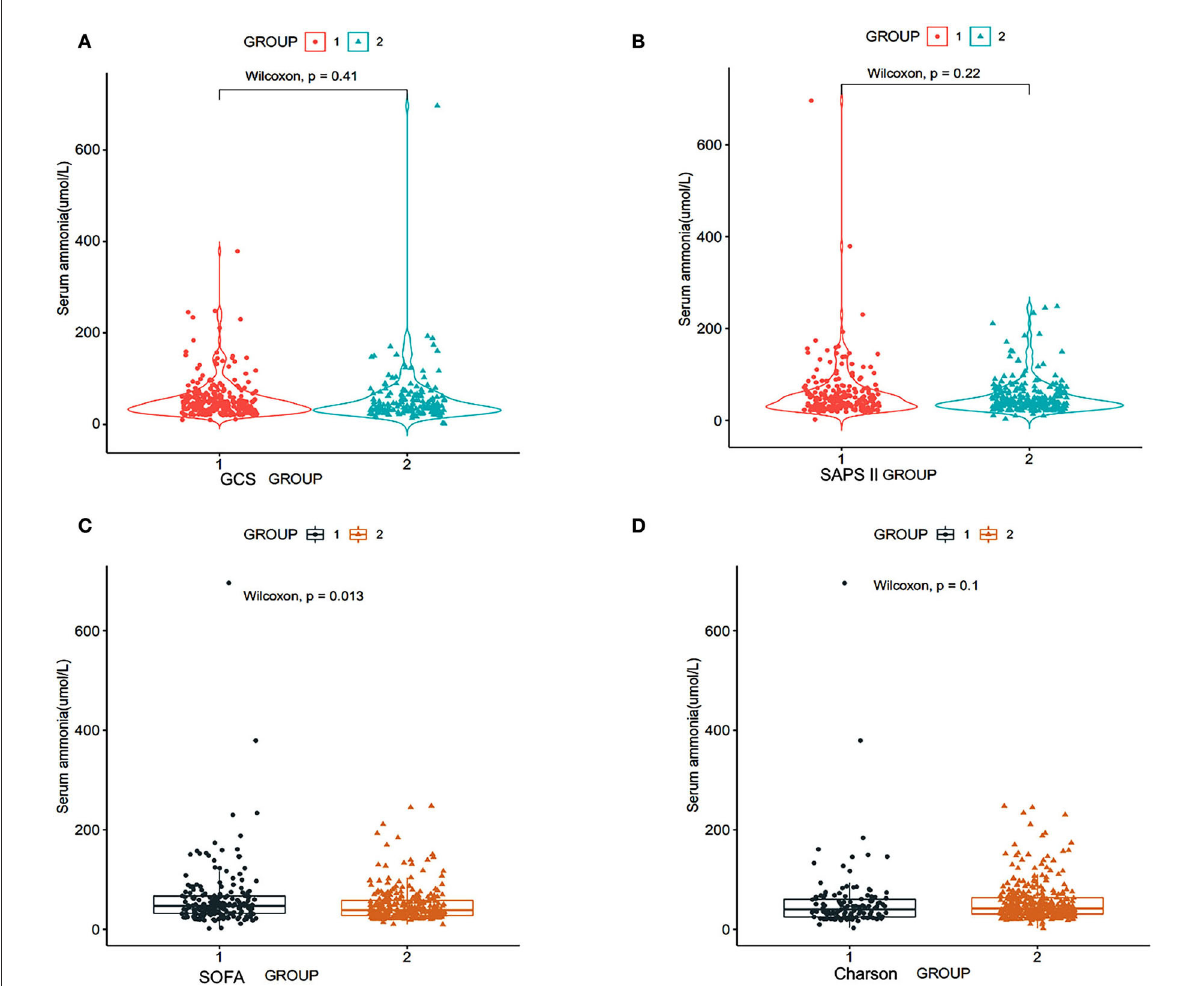
FIGURE2 Relationship between serum ammonia and SOFA scores of patients with SAE, SAPS II, GCS, and Charlson scores. SOFA, sequential organ failure assessment; SAPS II, simplified acute physiology score; GCS, Glasgow coma scale (RStudio, Version 1.3.1056, USA). (A) Group 1: GCS score of patients ≥ 9 scores, group 2: GCS score of patients ≤ 8 scores; (B) group 1: SAPS II score of patients ≥ 40 scores, group 2: SAPS II score of patients ≤ 39 scores; (C) group 1: SOFA score of patients: ≥ 8 scores, group 2: SOFA score of patients ≤ 7 scores; (D) group 1: Charlson score of patients ≥ 8 scores, group 2: Charlson score of patients ≤ 7